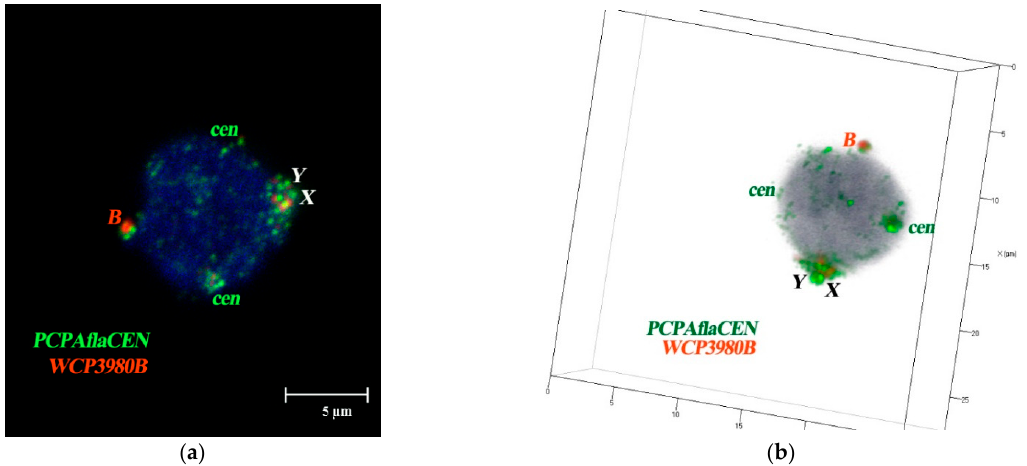
Figure 6. S-FISH of B-specific Whole Chromosome Paint (WCP3980B, red signal) and PCPAflaCEN probe (green signal) with the interphase nuclei of bone marrow cells of A. flavicollis male #24448 (1B, Novgorod region, Russia). ( a ) Maximum intensity projection; ( b ) three-dimensional reconstruction. Bs, X and Y chromosomes are marked by corresponding letters, “ cen” indicates autosomal C-positive regions; DAPI staining is blue; magnification is 63×. Conditions of scanning are the following: laser lines 405, 488; filters BP 420-480 IR and BP 505-570. Thickness of optical slice is 0.6 µm.